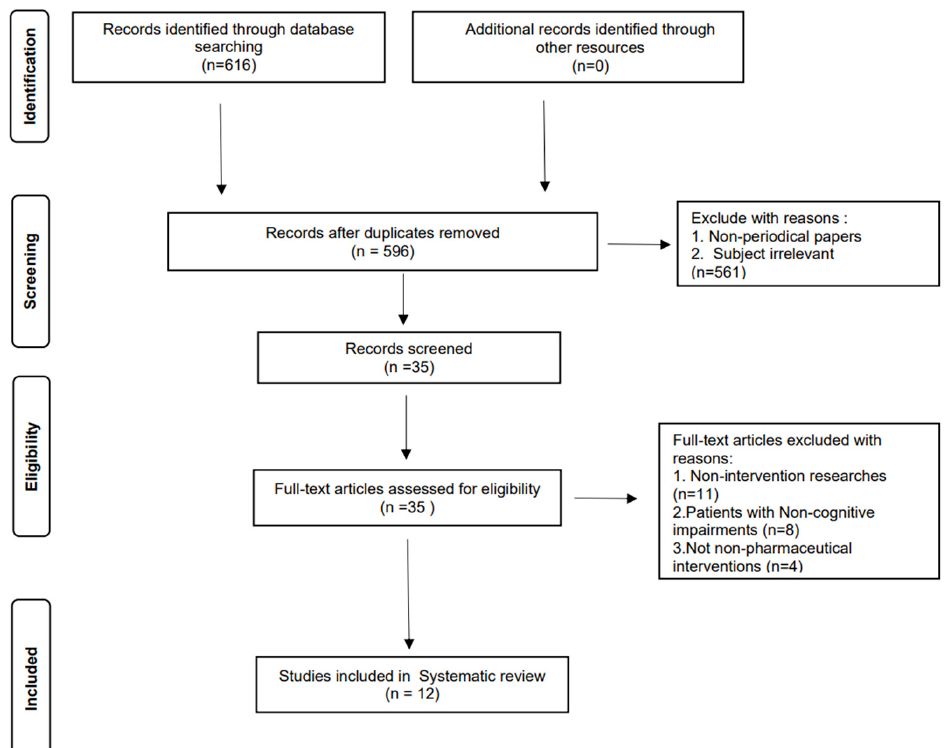
Figure 1. F low diagram of this study. Figure 1. Flow diagram of this